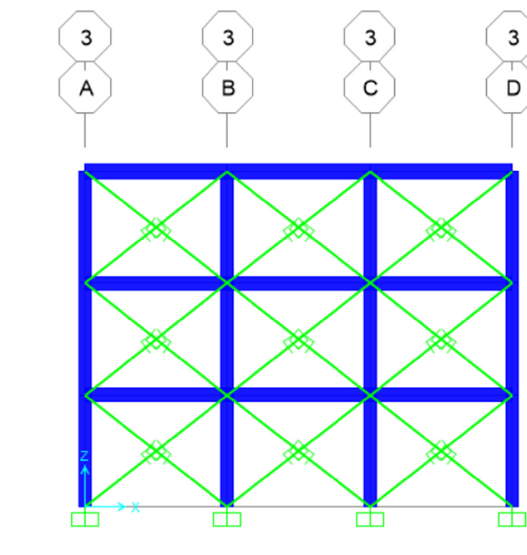
Table 2. Earthquake sequence used for time history analysis (retrieved from https://www.strong- motioncenter.org/, accessed on 15 March 2022).